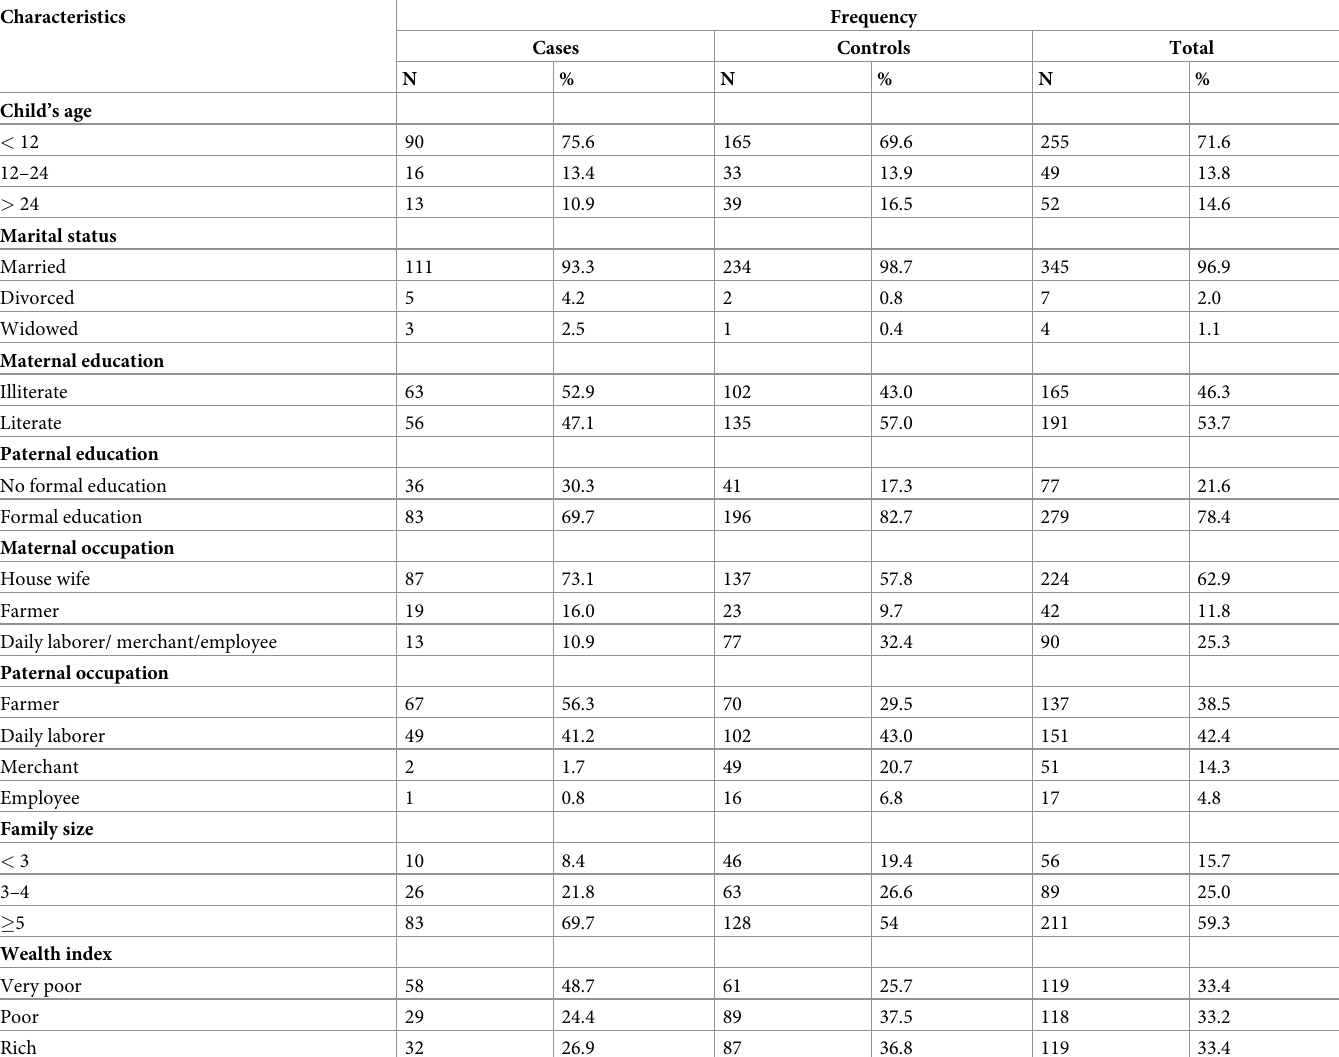
Table 1. Socio-demographic and economic characteristics among children aged 6–59 months in Wonago Woreda, South Ethiopia, November